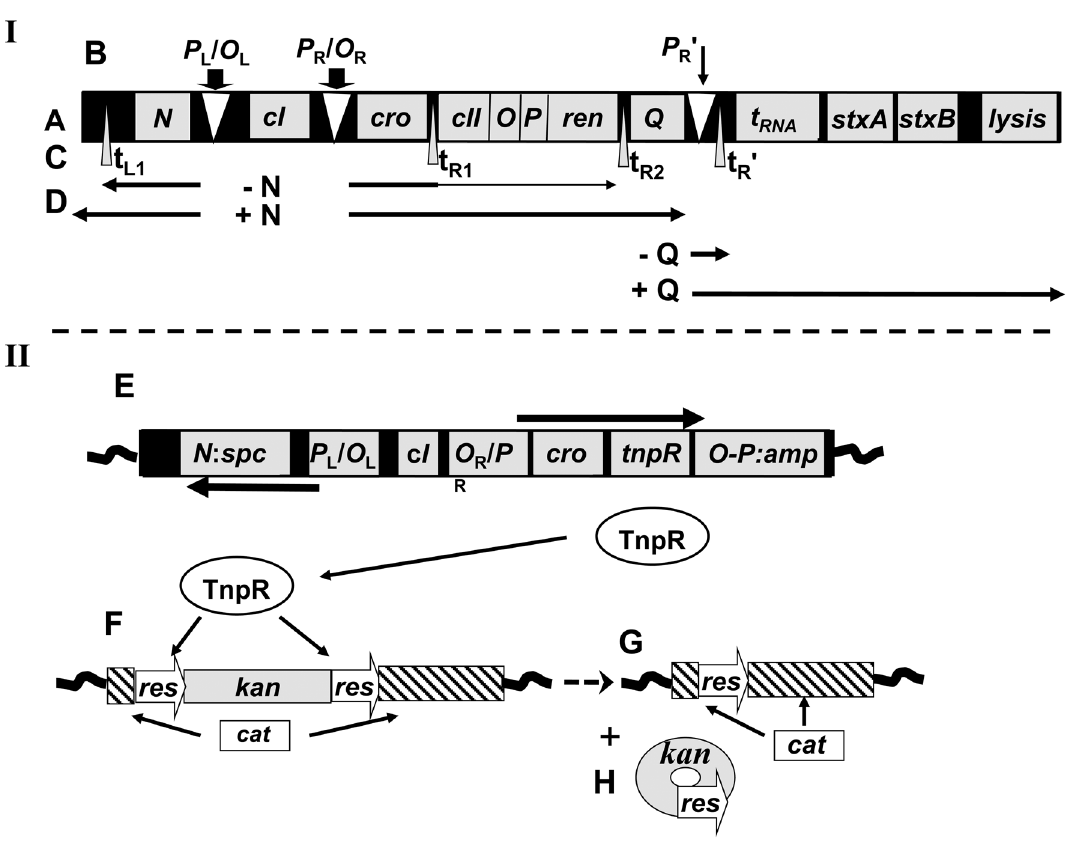
Figure 1. Diagrams illustrating genetic arrangements and constructs. I. The regulatory region of stx -carrying lambdoid phage and patterns of regulated transcription (not drawn to scale) (A) Arrangement of relevant genes. (B) Operators and promoters. (C) Transcription terminators. (D) Transcription patterns based on studies with l . Temporal order: Early transcripts from P L and P R ending at indicator terminators, with , 40% transcending t R1 . Action of antitermination protein N allows synthesis of delayed early transcripts. Action of antitermination protein Q immediately downstream of P R 9 allows maximum synthesis of late transcripts that include the stx genes. II. Components of SIVET (not drawn to scale). Top: (E) The early regulatory region of the 933W SIVET prophage. Deletion substitutions, N :: spc and O-P :: amp eliminate lethality by the induced prophage. The tnpR gene encodes the cd resolvase and is transcribed from the prophage P R promoter and under control of the 933W repressor. Hence, TnpR is not expressed by the repressed lysogen, but is expressed when induction leads to autocleavage of the phage repressor. Bottom: (F) SIVET reporter cassette with the cat gene interrupted with a kanR cassette flanked by resC sites (targets for TnpR resolvase). In this form the reporter cassette confers KanR. (G) Action of TnpR removes the kanR cassette and one flanking resC site. This leaves the cat gene interrupted by one resC site on the bacterial chromosome. By proper designing the position of the insertion site of the cassette in the cat gene of the reporter cassette as well as engineered small nucleotide changes in the res sequence, excision of the kanR cassette leaves a functional cat gene even though a resC sequence remains within the cat gene (confers CamR) [47]. (H) The kanR cassette with the other resC site is excised as a non-replicating circle and lost by segregation. The thick horizontal arrows in E represent patterns of transcription from early promoters following induction, loss of repression.